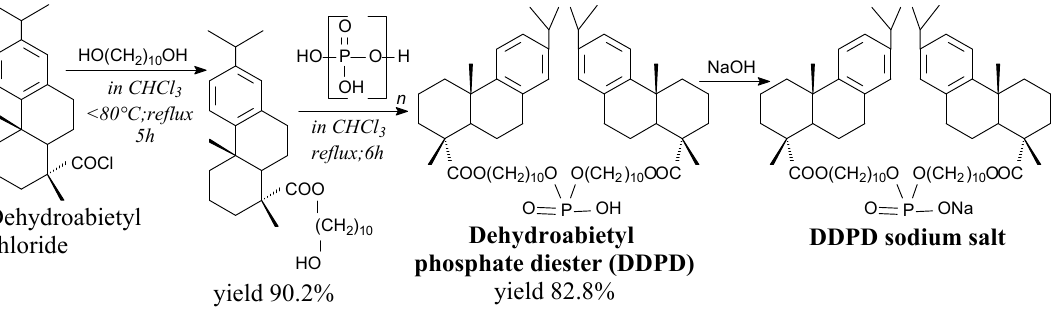
Scheme 25. Synthesis of tall oil-based polyol.